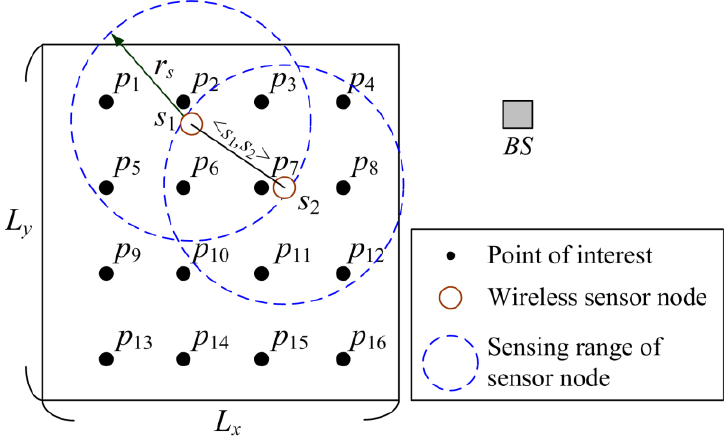
Figure 1. Example for the coverage model of sensor